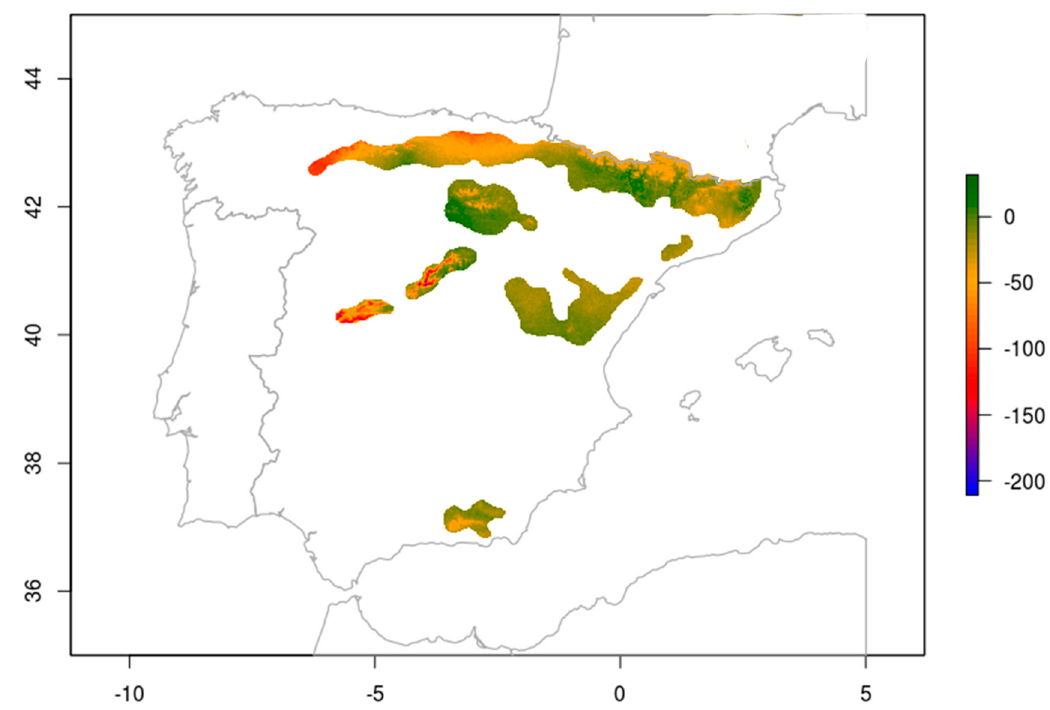
Figure A3. Spring precipitation anomaly between year 2070 (RCP 8.5) and current climate (baseline: average climate calculated for the period 1970–2000).